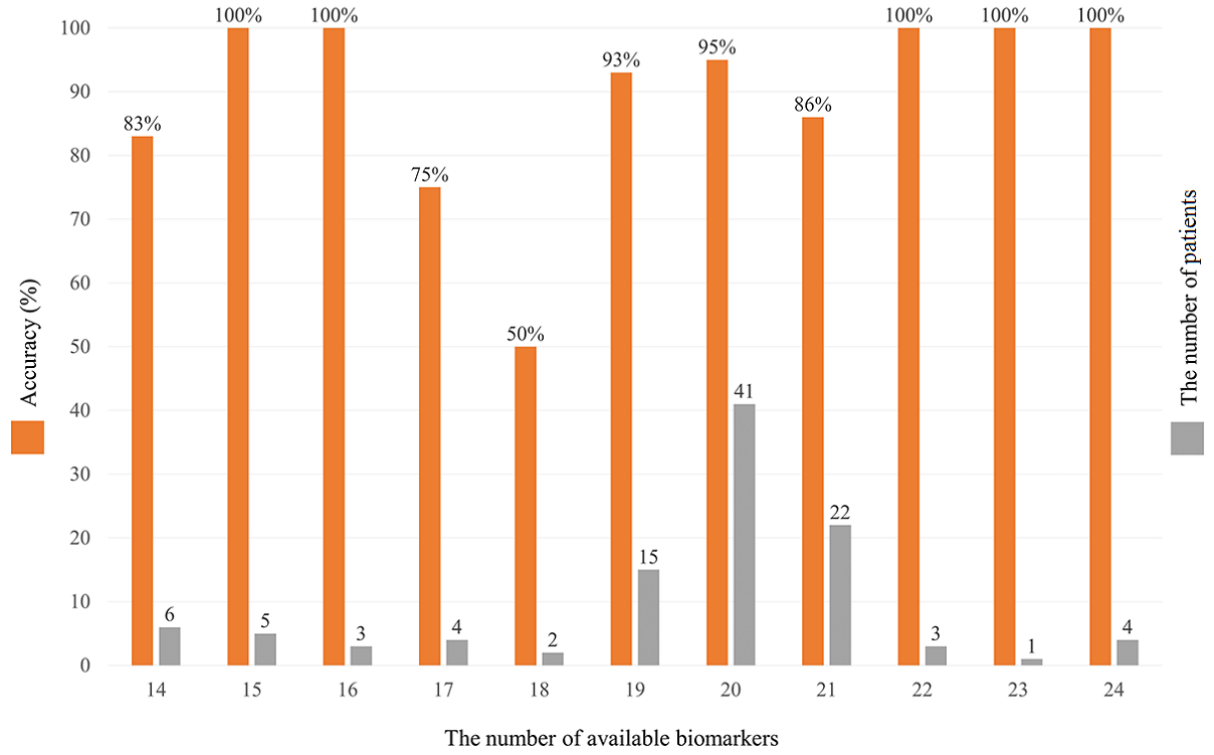
Figure 2. Accuracy with the number of available blood biomarkers from the 106-patient testing data set.